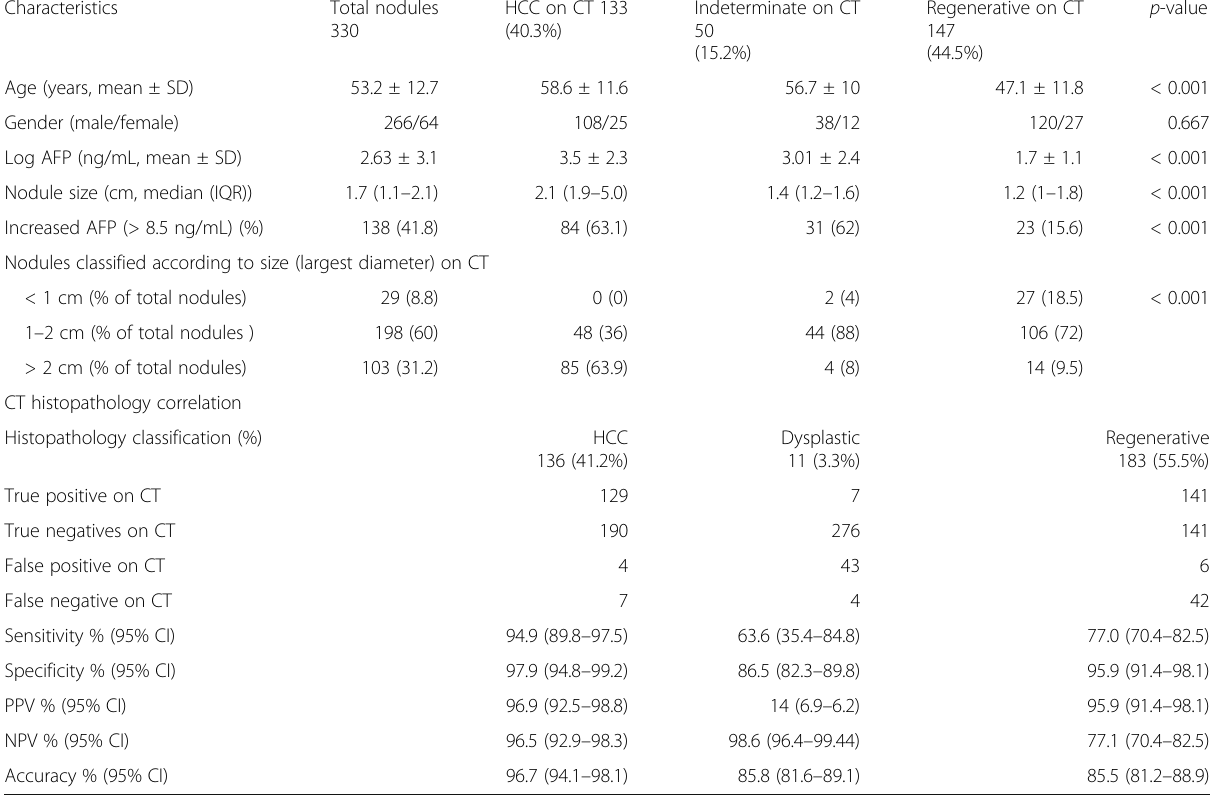
Table 2 Characteristics of patients with CT diagnosis of liver nodules and histopathology correlation